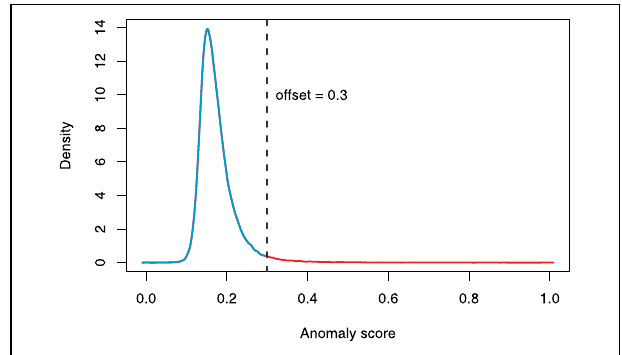
FIGURE 2 | The density curve of the anomaly scores of the entire data points. The vertical dashed line marks the offset, which is 0.3 for this particular